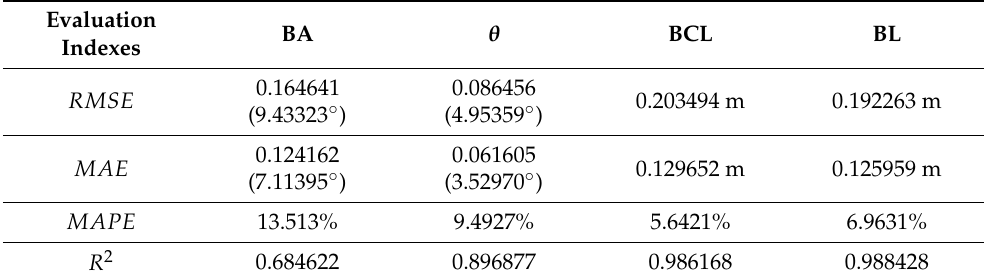
Figure 10. The scatter plot of each branch attribute. Table 3. Accuracy of attribute values of